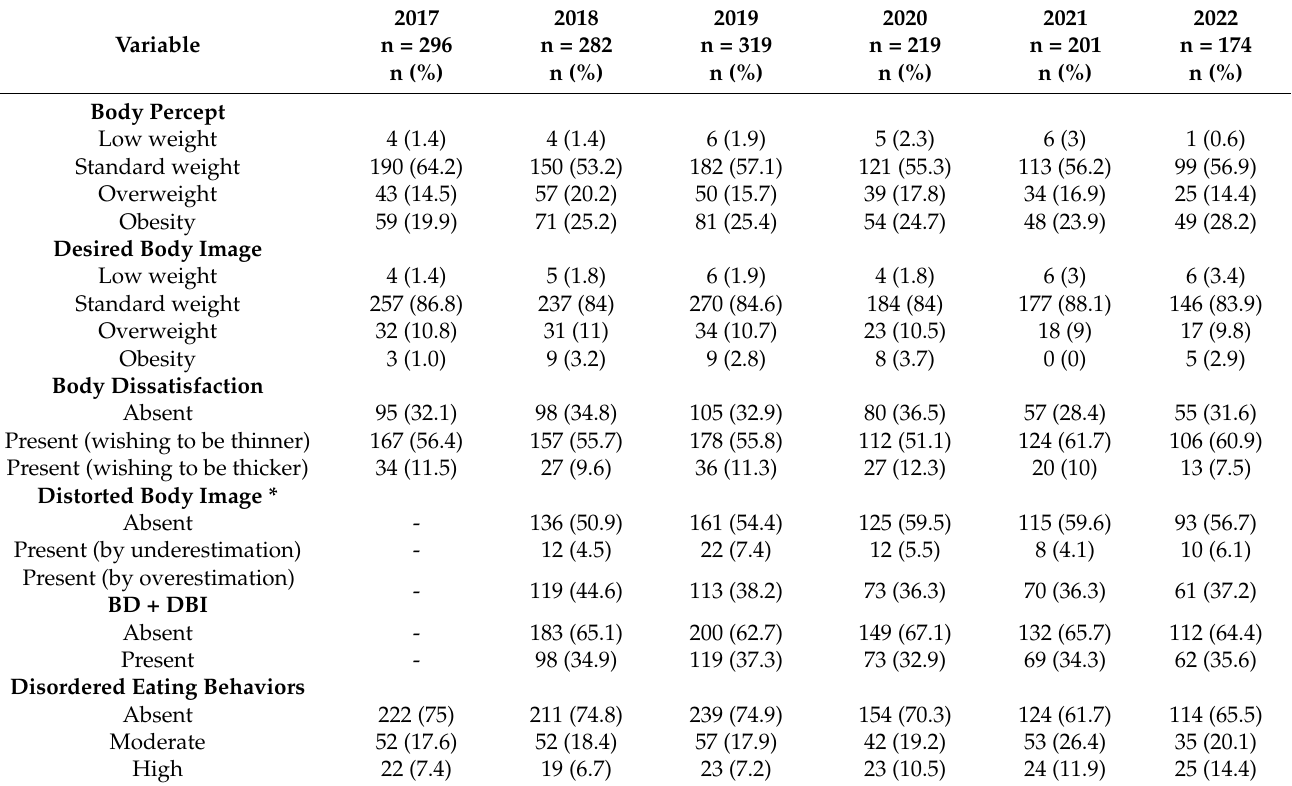
Table 2. Prevalence of Body Image-related variables in university students